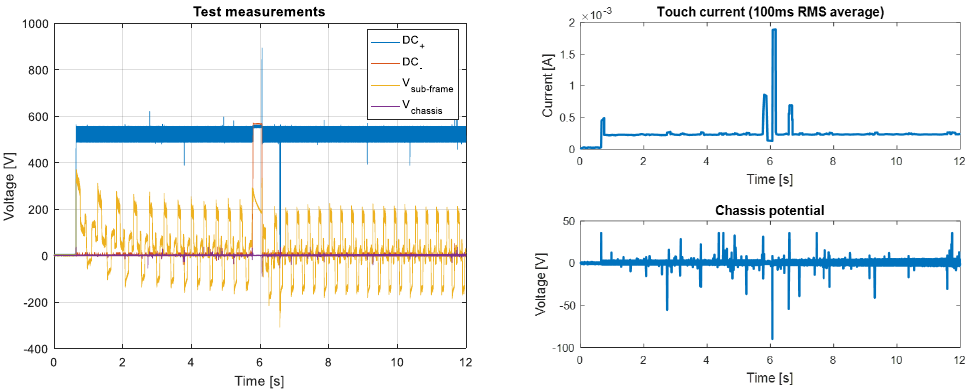
Figure 7. Measured voltages referred to earth ( left ), touch current RMS value over 100 ms ( right , top ), and chassis potential ( right , bottom ) under a loss of connection to the negative rail.